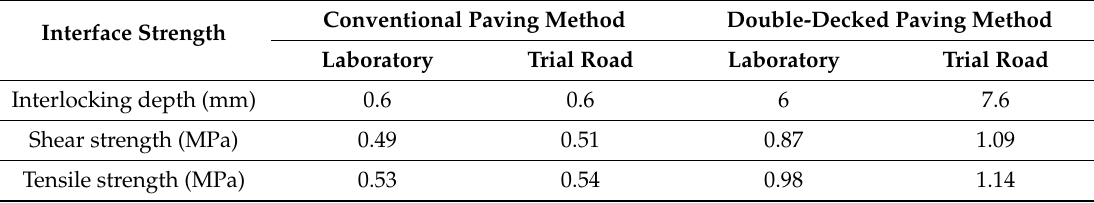
Table 7. Comparison of interface strength of specimens obtained from the laboratory and the trial